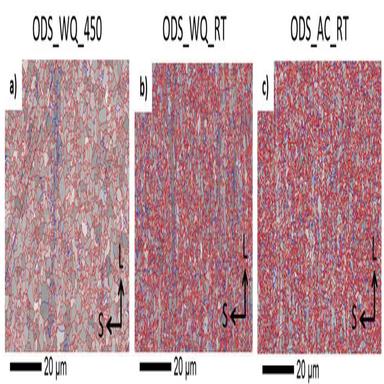
EBSD grain boundary maps of a) ODS_WQ_450, b) ODS_WQ_RT and c) ODS_AC_RT specimens. HAGBs (grain boundary misorientation angle ≥ 15°) and LAGBs (grain boundary misorientation angle between 5° and 15°) are coloured red and blue, respectively. (For interpretation of the references to color in this figure legend, the reader is referred to the web version of this article.)